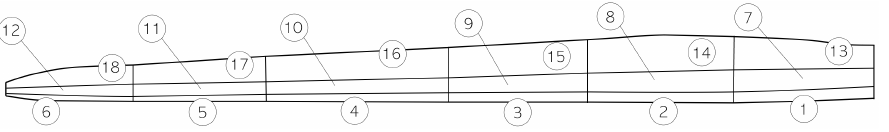
Figure 3. Blade’s outer skin regions divided in 18 regions containing a different composite layup.